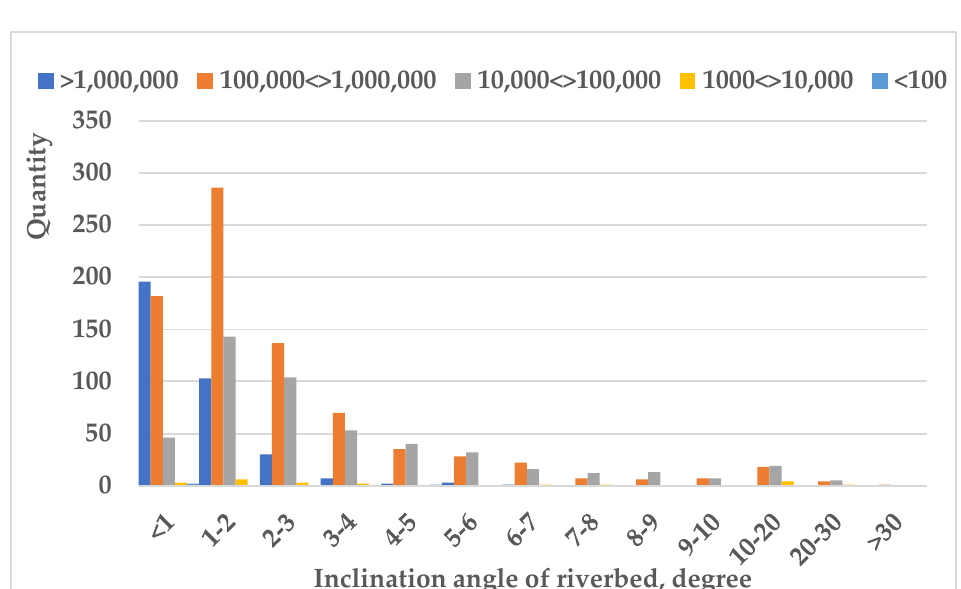
Figure 10. Plot of Aufeis number versus inclination angle for Aufeis bed surfaces in the Kunlun Mountains on the northern edge of the Qinghai-Tibet Plateau, West China Mountains Aufeis sizes are reflected by colours (in m 2 )